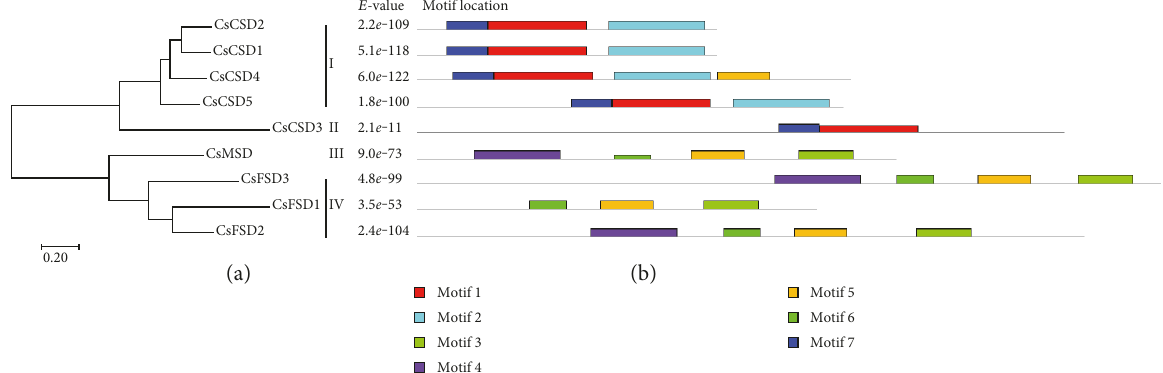
Figure 1: Unrooted neighbor-joining phylogenetic tree and conserved motif analysis of CsSOD proteins. (a) Phylogenetic tree was generated based on the protein sequences of CsSOD proteins. (b) Conserved motif analysis of CsSOD proteins. Di ff erent color boxes represent di ff erent types of